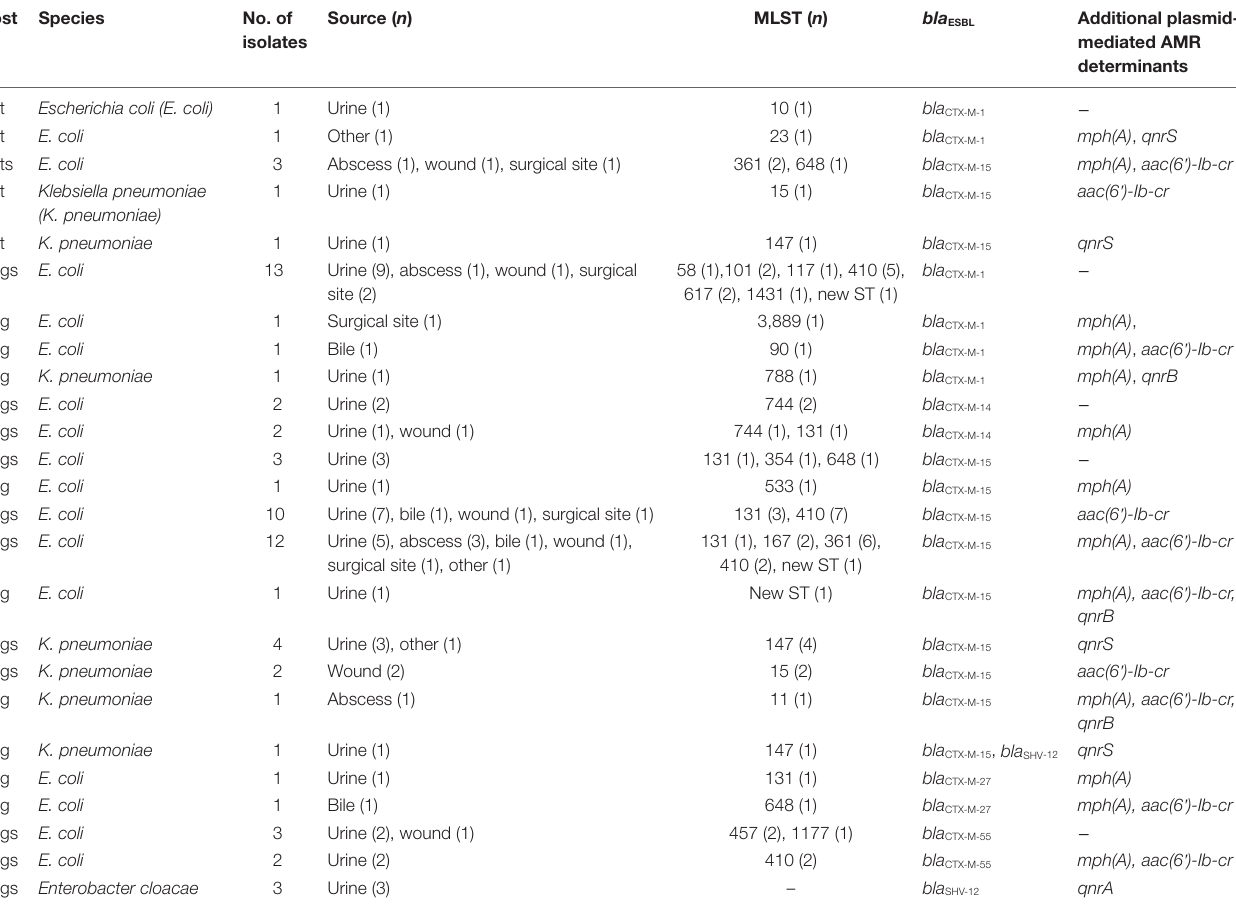
TaBle 2 | Type and distribution of extended-spectrum β -lactamases (ESBL) genes and other plasmid-mediated resistance genes among 72 clinical Enterobacteriaceae isolated from cats and dogs in Switzerland, 2012–2016. host species no. of source ( n ) isolates